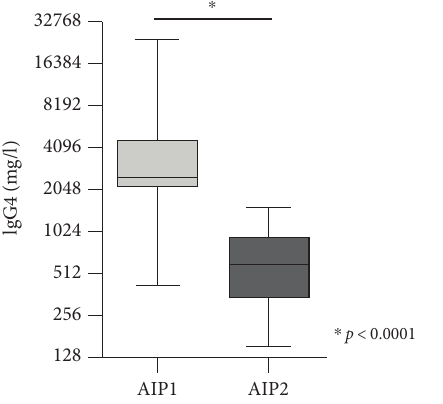
Figure 4: Serum levels of IgG4 are signi fi cantly increased in patients with AIP1.